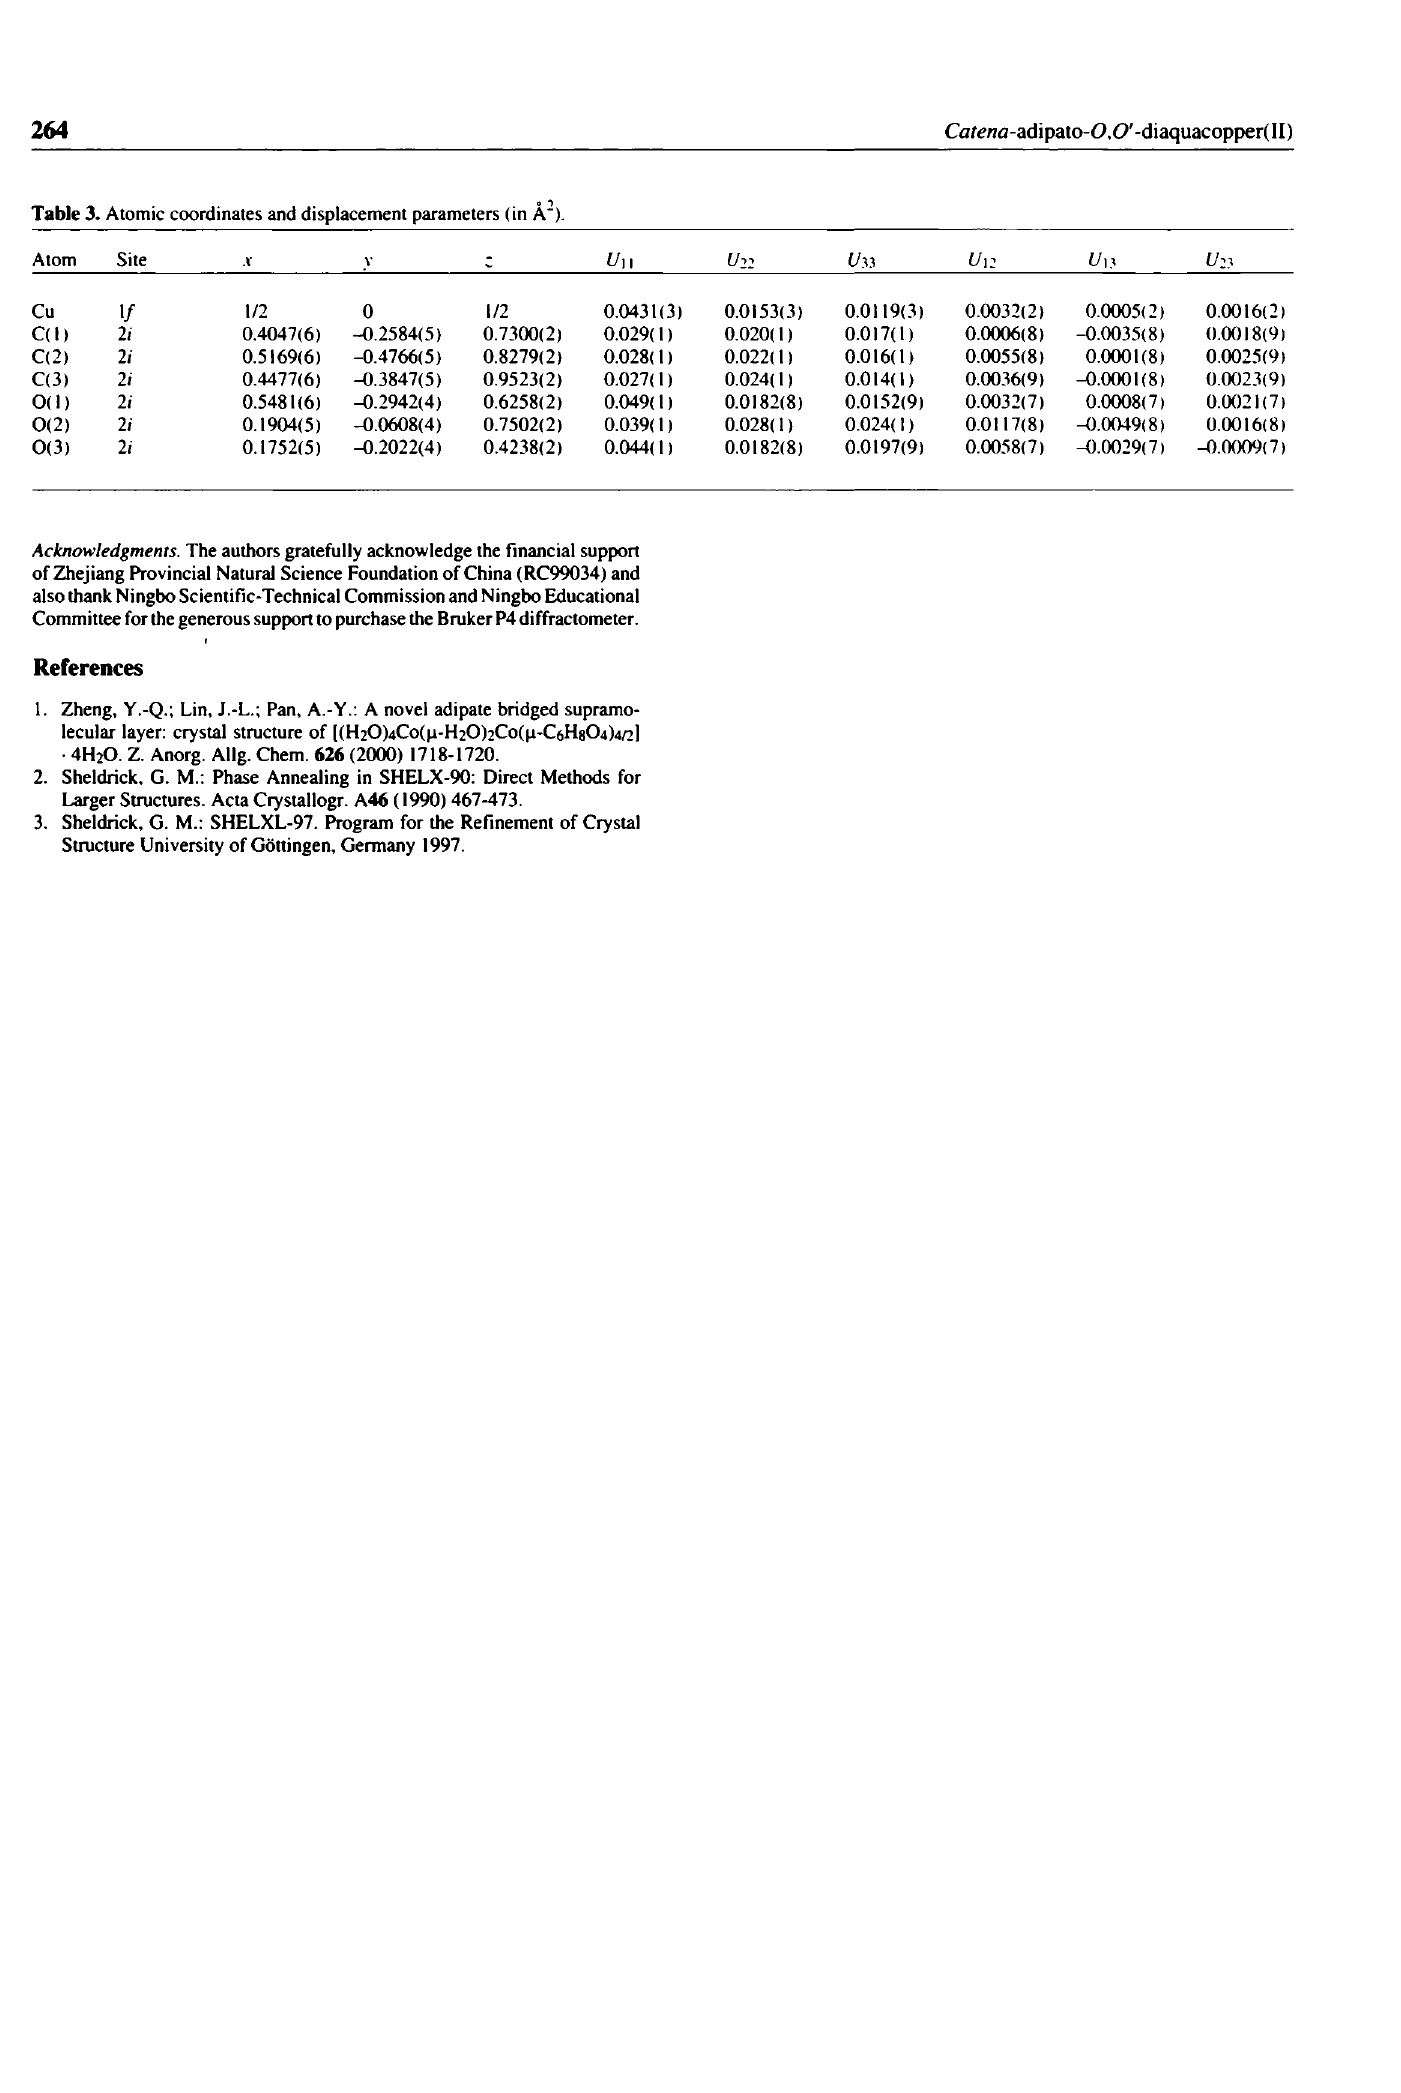
Table 3. Atomic coordinates and displacement parameters (in A 2